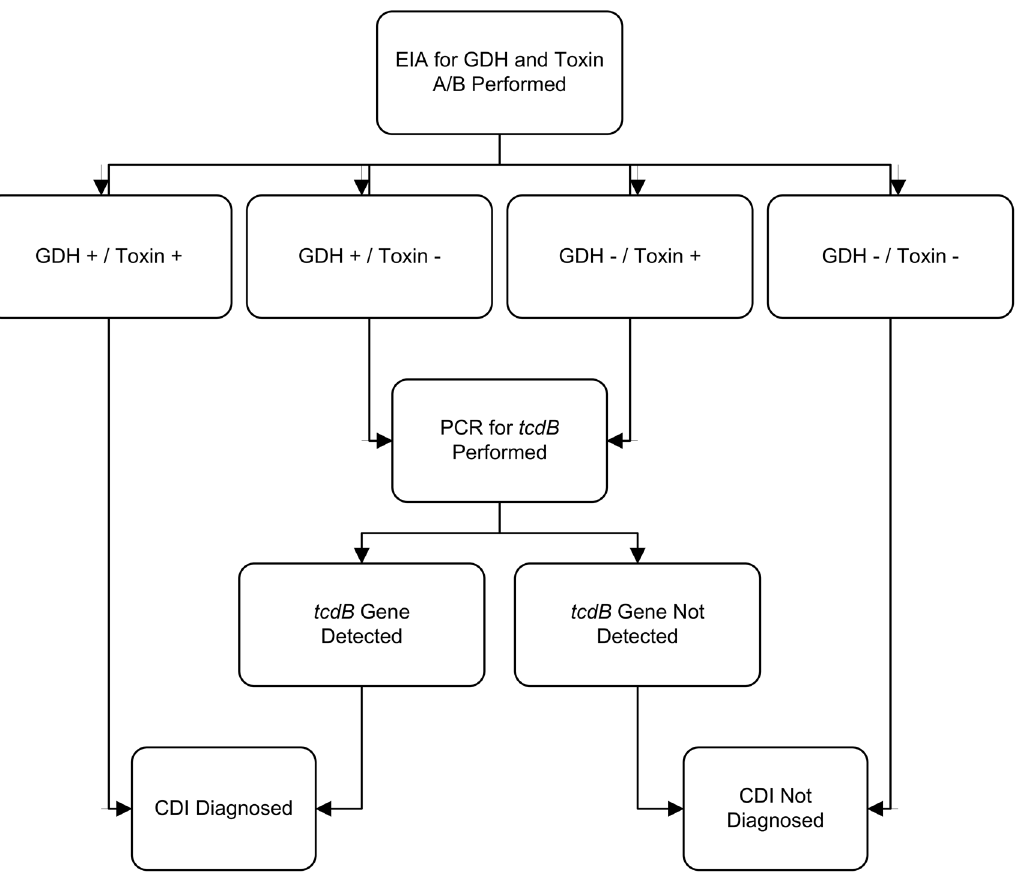
Figure 1. Testing algorithm for Clostridiumdifficile infection. This flow diagram illustrates this University of Michigan diagnostic testing algorithm for detecting toxigenic Clostridium difficile in stool. Abbreviations : CDI, Clostridium difficile infection; EIA, enzyme immunoassay; GDH, glutamate dehydrogenase; PCR, polymerase chain reaction.